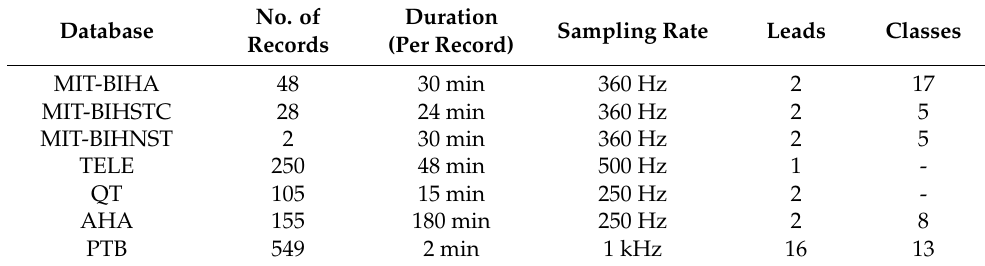
Table 1. Detail of ECG